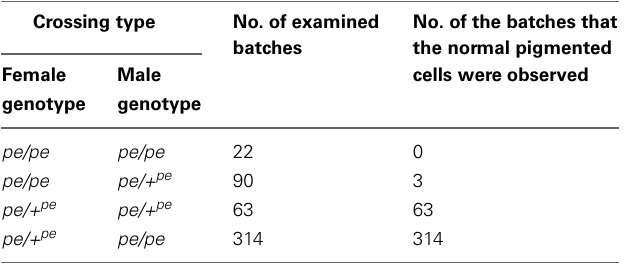
Table 1 | The black pigmented cells in the white eggs. Crossing type No. of examined